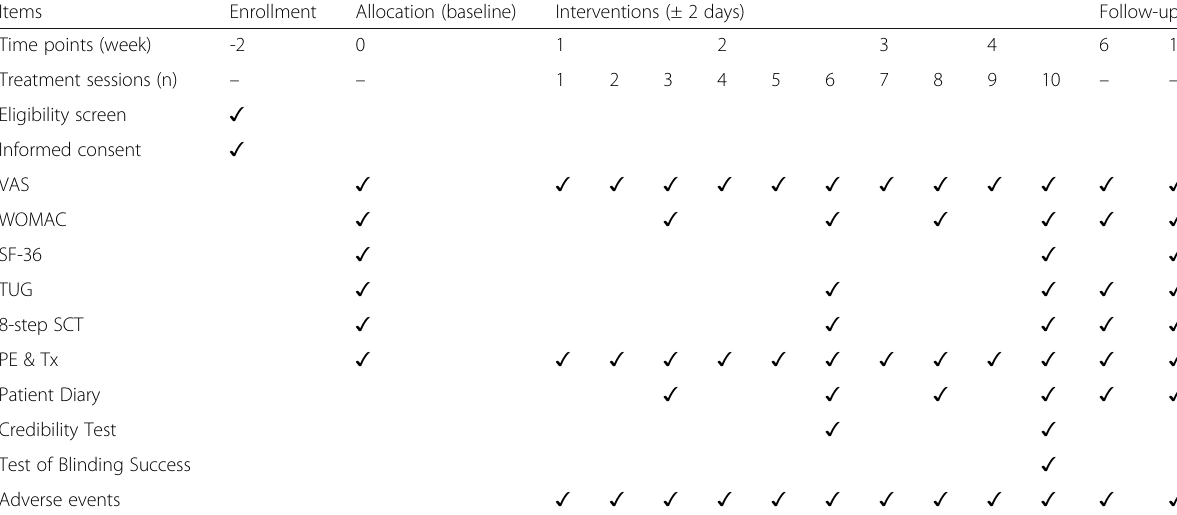
Table 1 The schedule of enrollment, interventions, and